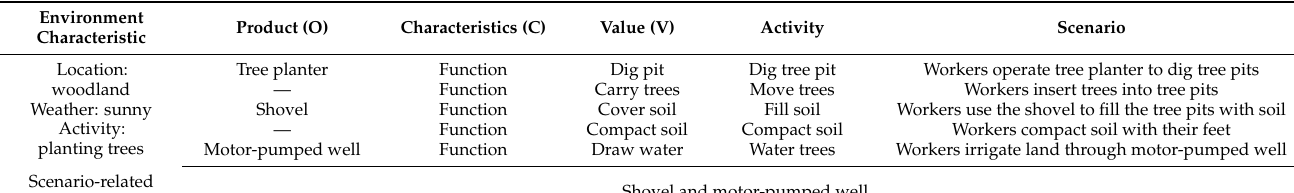
Table 4. Process of acquiring scenario-related products based on the object.